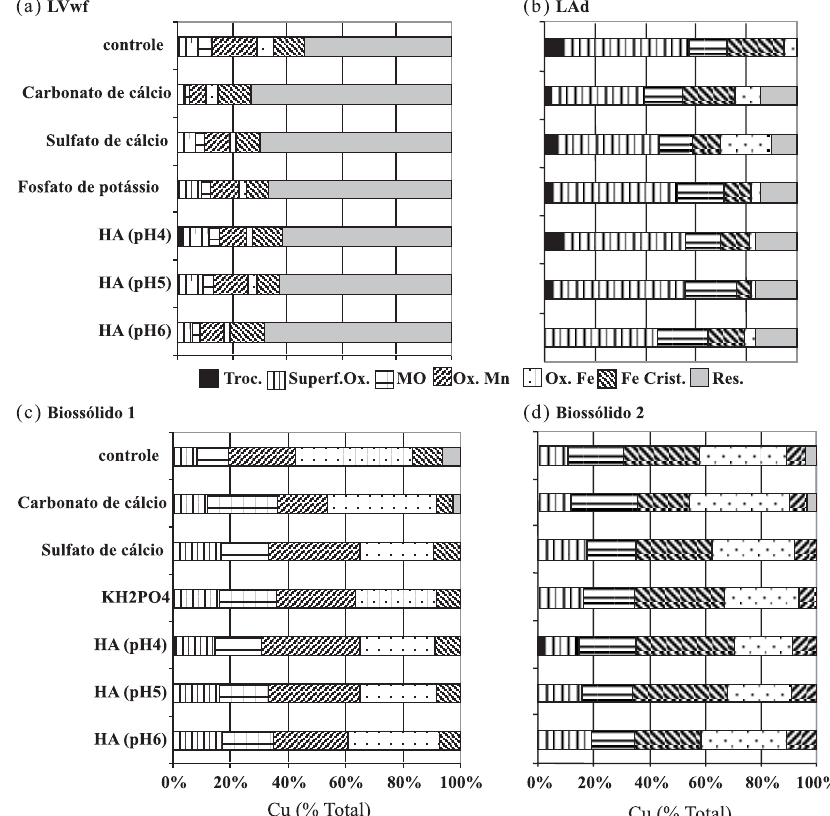
Figura 5. Distribuição das formas de cobre nas amostras de solo e biossólido após os equilíbrios nas câmaras duplas de difusão. LVwf: Latossolo Vermelho acriférrico; LAd: Latossolo Amarelo distrófico; Biossólido 1: biossólido equilibrado com LVwf; Biossólido 2: biossólido equilibrado com LAd; Troc.: trocável; Superf. Ox.: superfície de óxidos; MO: matéria orgânica; Ox. Mn: óxidos de Mn; Ox. Fe: óxidos de Fe mal- cristalizados; Fe Crist.: óxidos de Fe cristalinos; Res.: